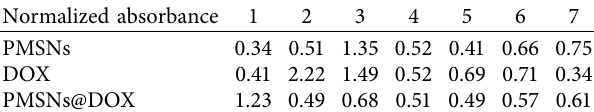
Table 2: Ultraviolet visible light absorption spectrum. Normalized absorbance